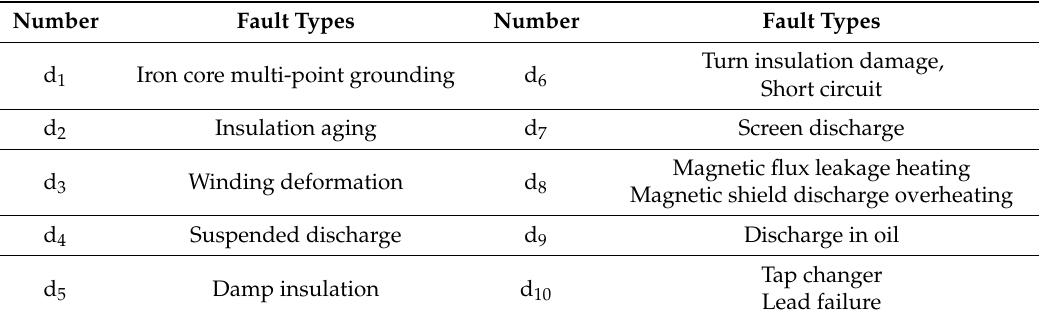
Figure 2. Structure and key components of the typical transformer. Table 2. Transformer fault